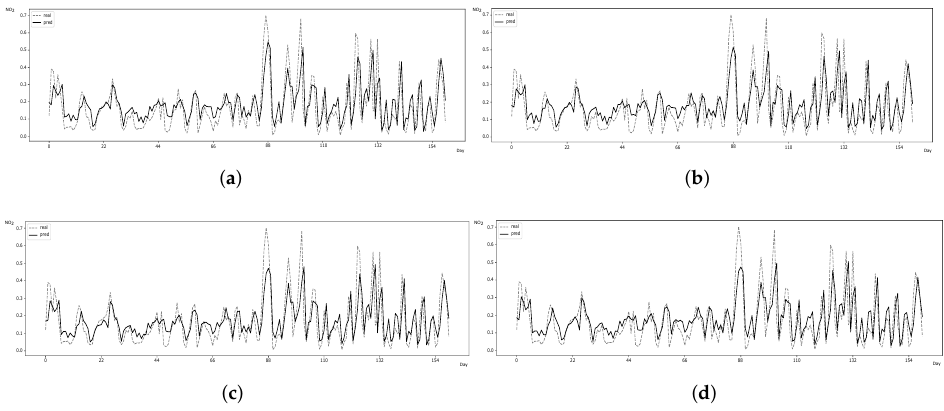
Figure 15. Predicted versus actual normalized output values considering changes in the number of recursive neurons used in the first LSTM layer. ( a ) First LSTM layer with 64 units. ( b ) First LSTM layer with 128 units. ( c ) First LSTM layer with 256 units. ( d ) First LSTM layer with 512